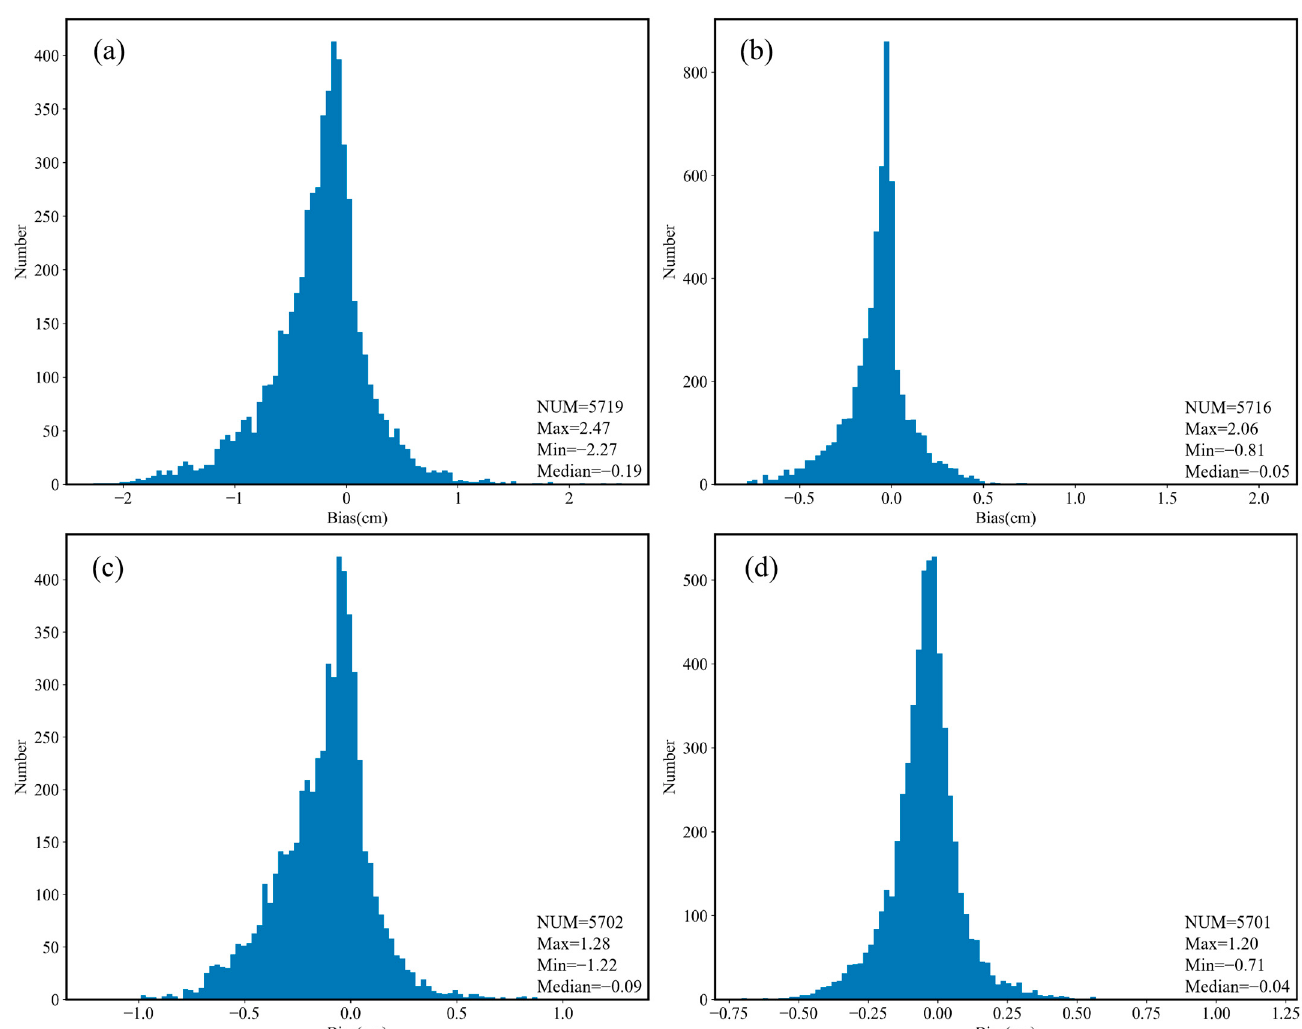
Figure 3. The histograms of the Bias. ( a ) Whole layer; ( b ) high layer; ( c ) middle layer; ( d ) low